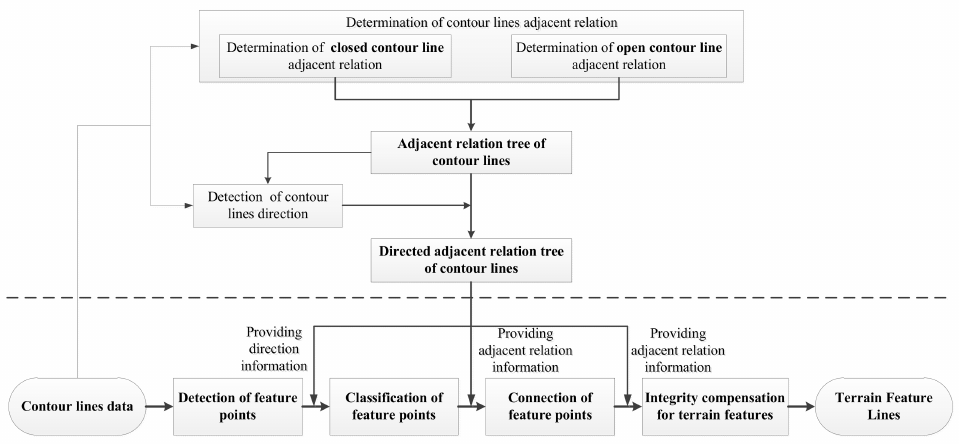
Figure 1. Framework of the proposed